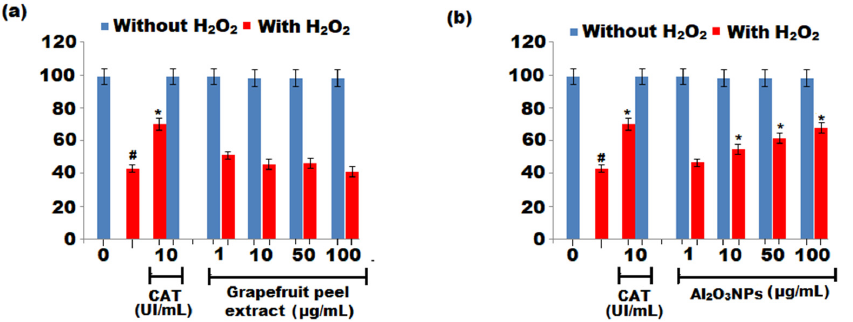
Figure 7. Protective effect of ( a ) grapefruit peels extract and ( b ) Al 2 O 3 NPs in RAW 264.7 macrophages towards damage caused by hydrogen peroxide (H 2 O 2 ). The results were represented as ± SD (n = 2). # Significant ( p < 0.05) and * Significant ( p < 0.05) compared to negative control without H 2 O 2 and H 2 O 2 control by one-way ANOVA.